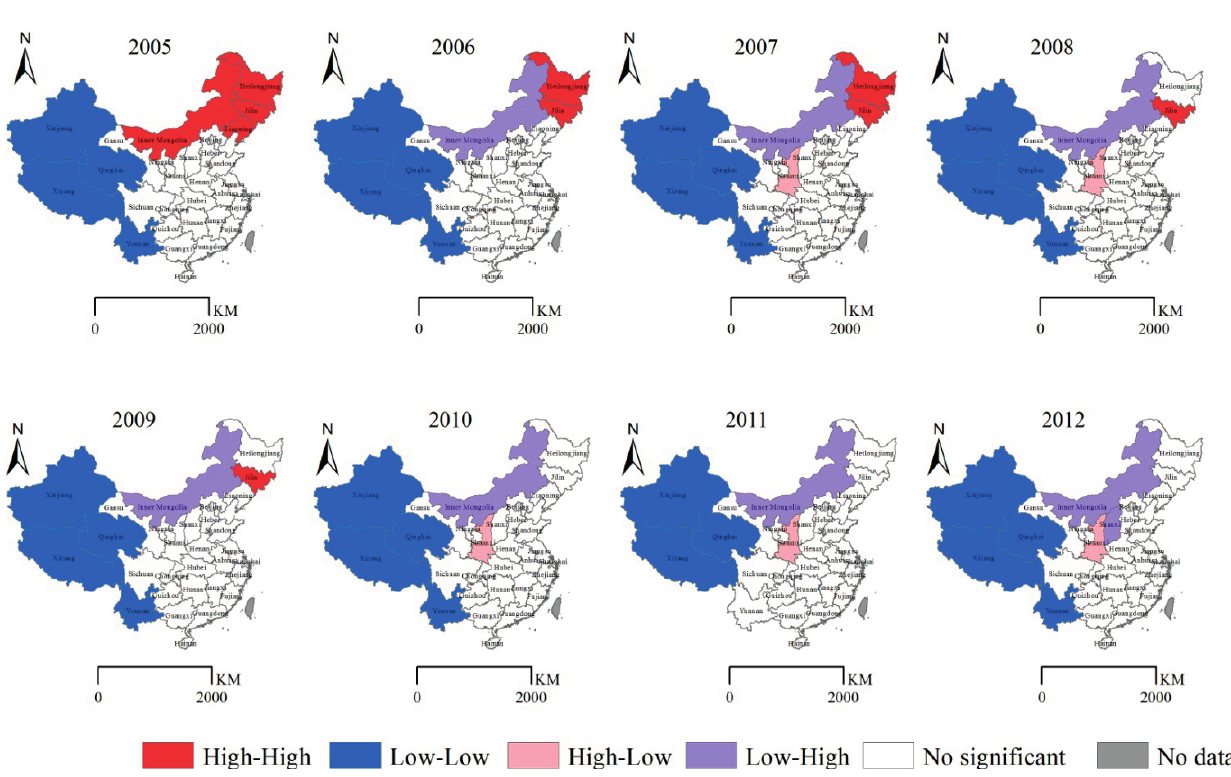
Figure 3. Yearly LISA cluster maps of hemorrhagic fever with renal syndrome (HFRS)